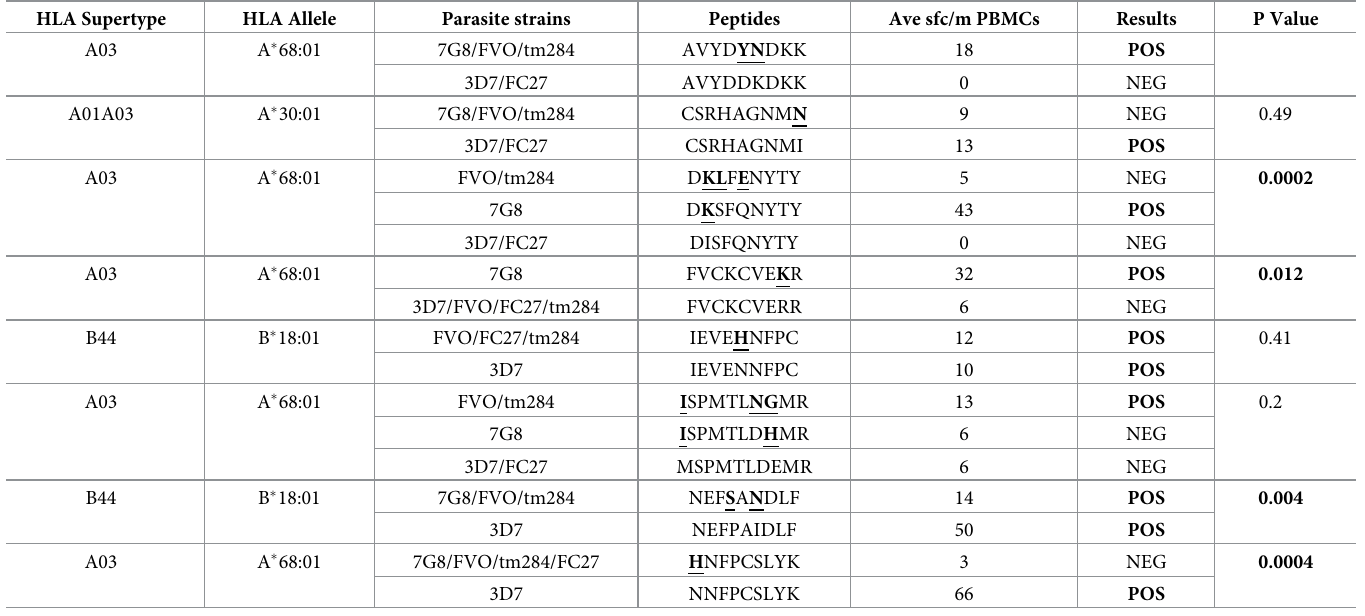
Table 1. Outcome of subject v01 PBMC stimulation with allelic peptide